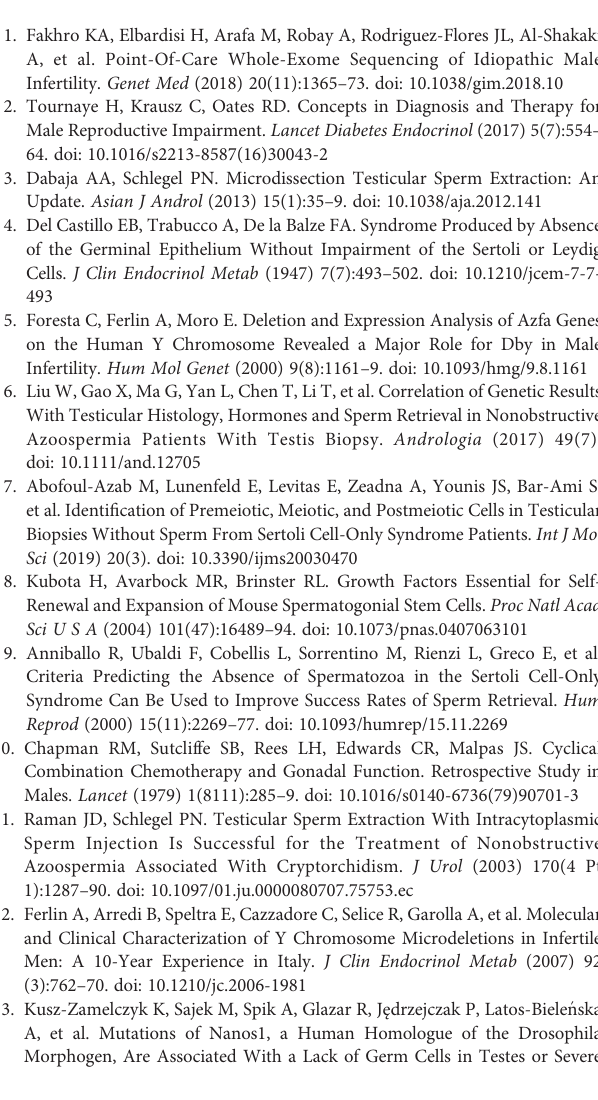
Supplementary Figure 6 | Differential eigengene network analysis based on the OA and SCOS groups. The dendrograms of consensus module eigengenes within the (A) OA and (B) SCOS groups. The adjacencies of consensus module eigengenes within the (C) OA and (D) SCOS groups. Red and blue in the heatmap show high and low adjacencies, respectively. (E) The preservation network for the OA and SCOS groups. (F) Bar graph indicating the preservation degree of the consensus eigengenes. OA, obstructive azoospermia; SCOS, Sertoli cell-only syndrome. Supplementary Figure 7 | Functional enrichment of genes within the SCOS- speci fi c green, red, or cyan module. SCOS, Sertoli cell-only syndrome. Supplementary Figure 8 | Functional enrichment of genes within SCOS-speci fi c brown, lightcyan, greenyellow, salmon, or gray60 module. SCOS, Sertoli cell- only syndrome. Supplementary Figure 9 | The forest plots showing the signi fi cant associations between hub genes and immune cells without CD56 bright natural killer